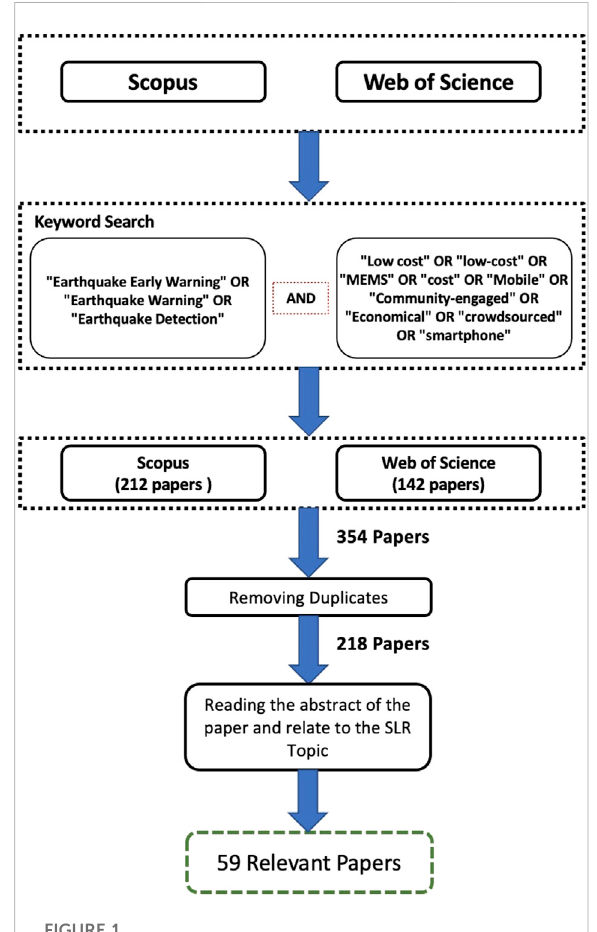
FIGURE 1 Systematic Literature Review process fl ow